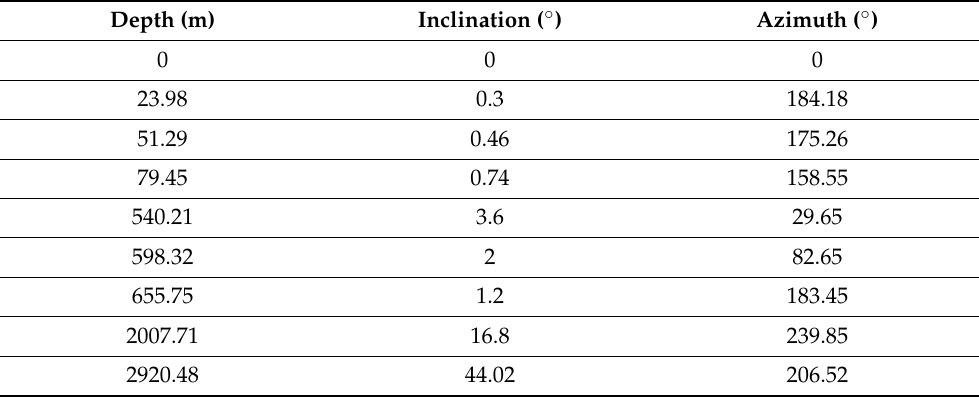
Table 1. Well trajectory data for well